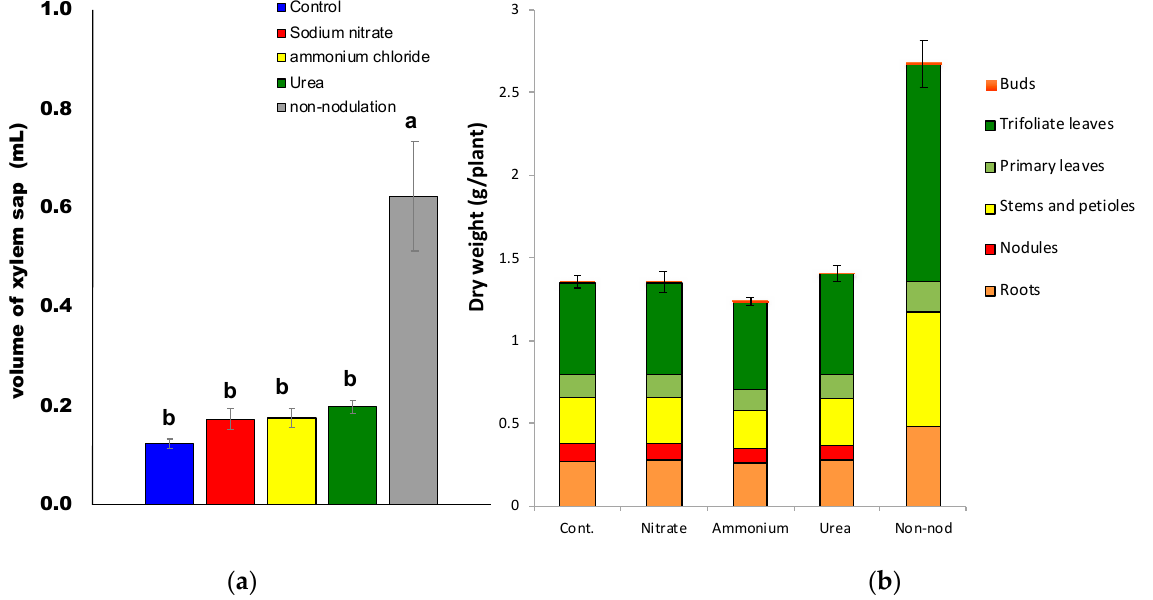
Figure 2. The volume of xylem sap ( a ) and dry weight ( b ) of soybeans after 3 d of N treatment 23 DAP. Different letters above the bars indicate significant differences ( p < 0.05) by Tukey’s test. Error bars indicate standard error (SE) from the four plants.